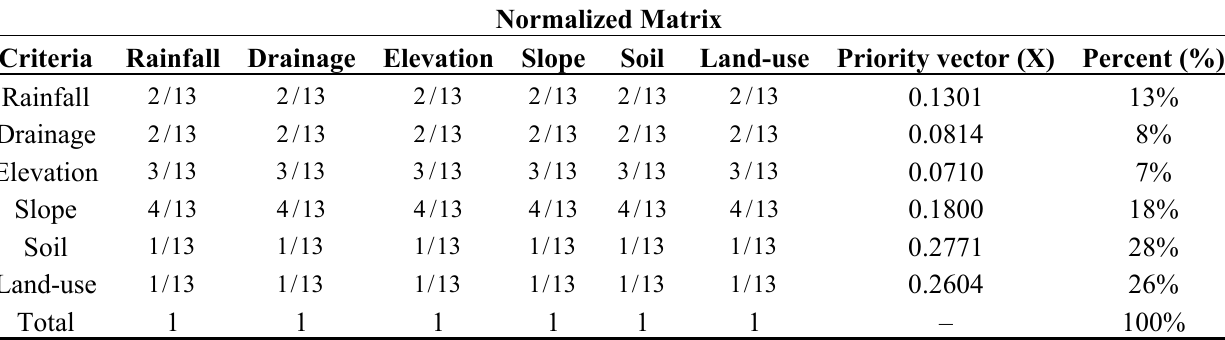
Table 4. Normalizing the criteria columns to obtain the normalized matrix. Normalized